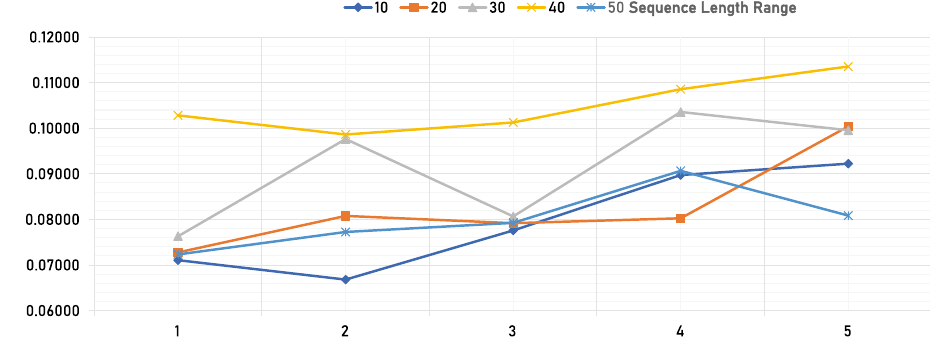
Fig. 10 A graphical summari- zation of the reported results using BiLSTM and “Ethereum USD (ETH-USD)”